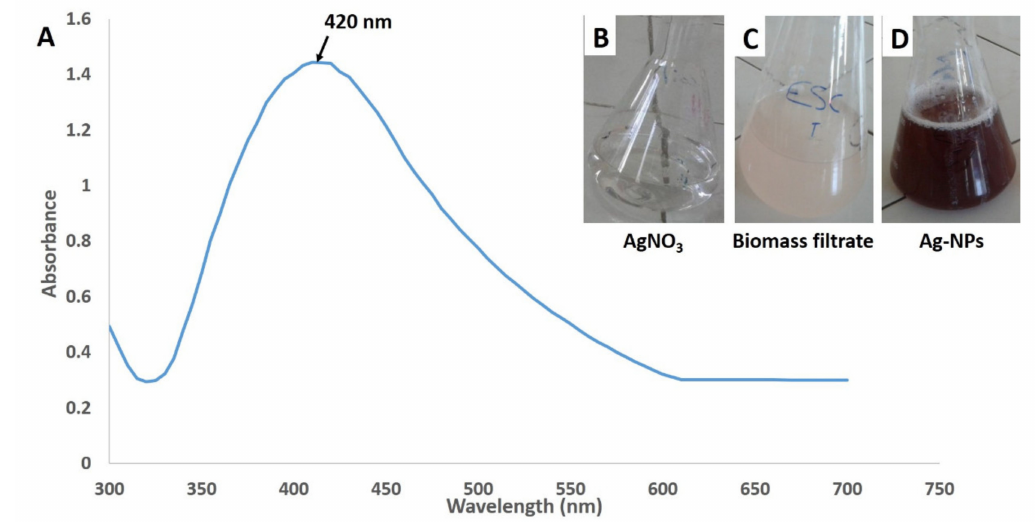
Figure 2. Ultraviolet-visible (UV-vis) spectroscopic analysis and the color change of silver nanoparticles (Ag-NPs) synthesized by endophytic S. laurentii R-1. ( A ) the UV-vis spectroscopy; ( B ) the AgNO 3 solution; ( C ) the S. laurentii biomass filtrate, and ( D ) the biosynthesized